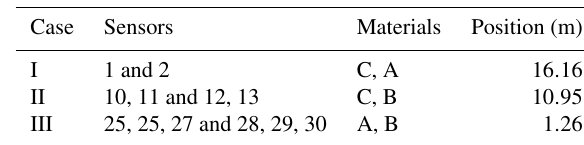
Table 4. The 1-D study comprises three different cases which inves- tigate the three materials with an increasing number of TDR sensors per material at different locations in ASSESS (Fig. 2). Note that each material is covered